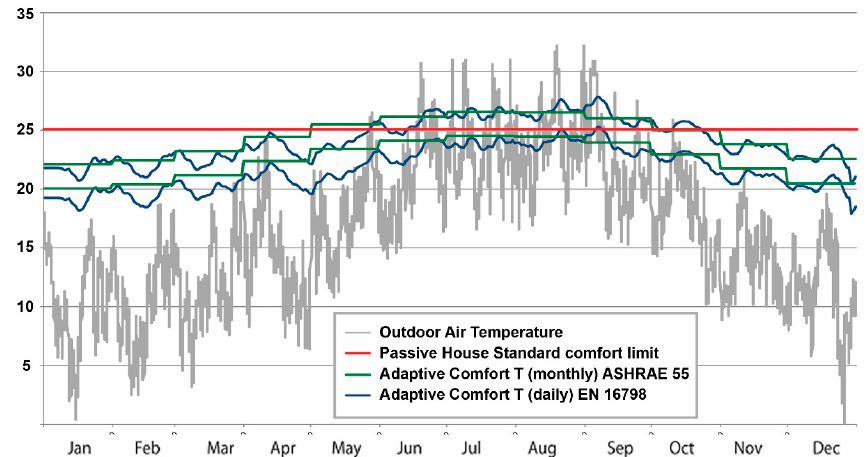
Figure 7. The comparison of four models concerning the outdoor operative temperature of Liege, in 2050, under Representative Concentration Pathways (RCP) 8.5 scenario. Energies 2020 , 13 , x FOR PEER REVIEW